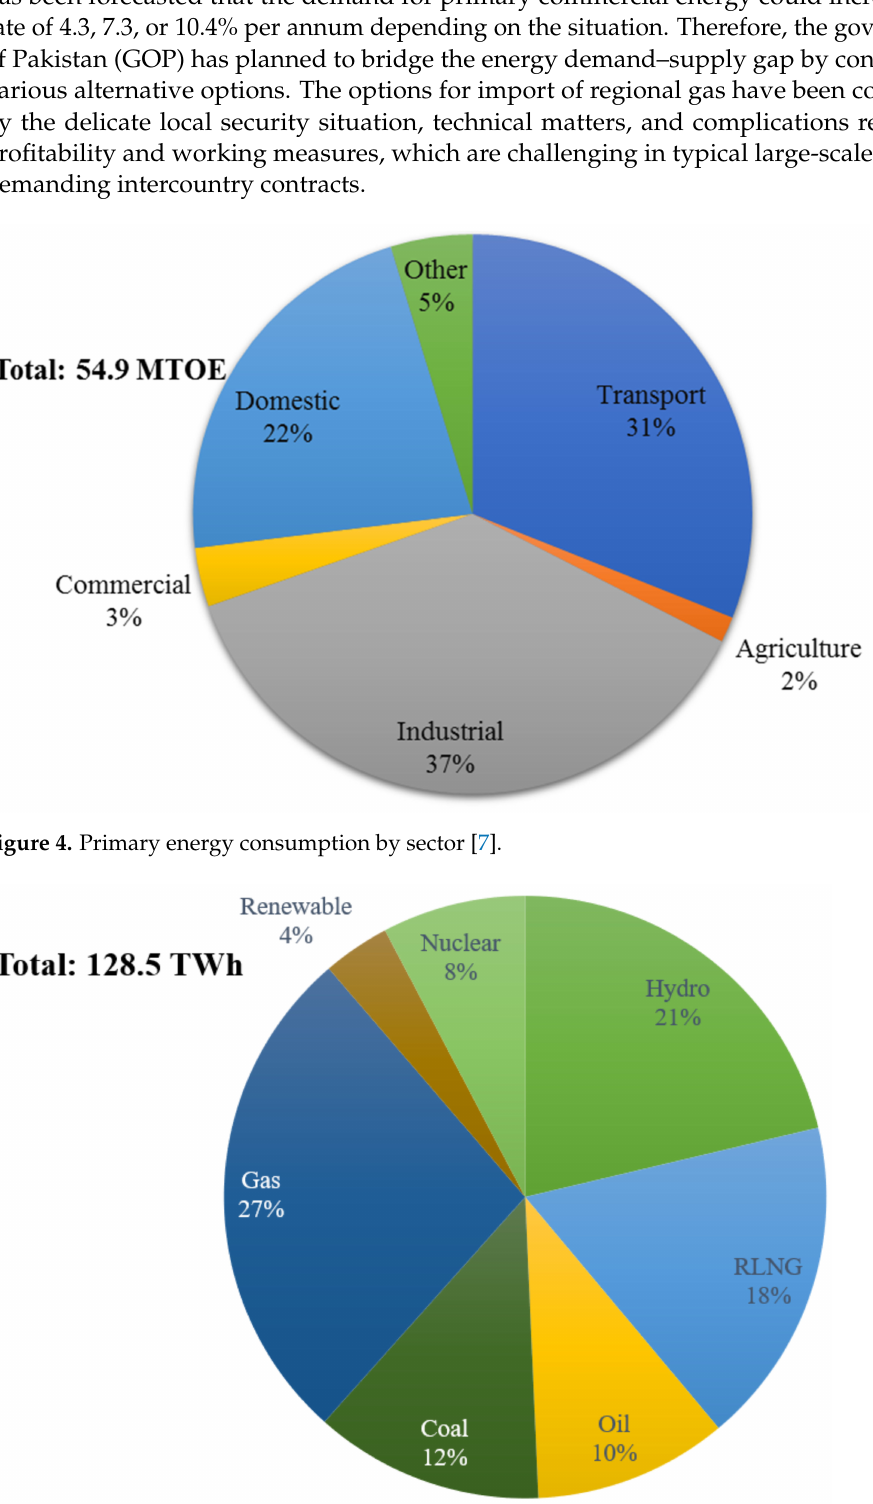
Figure 5. Electricity generation by source